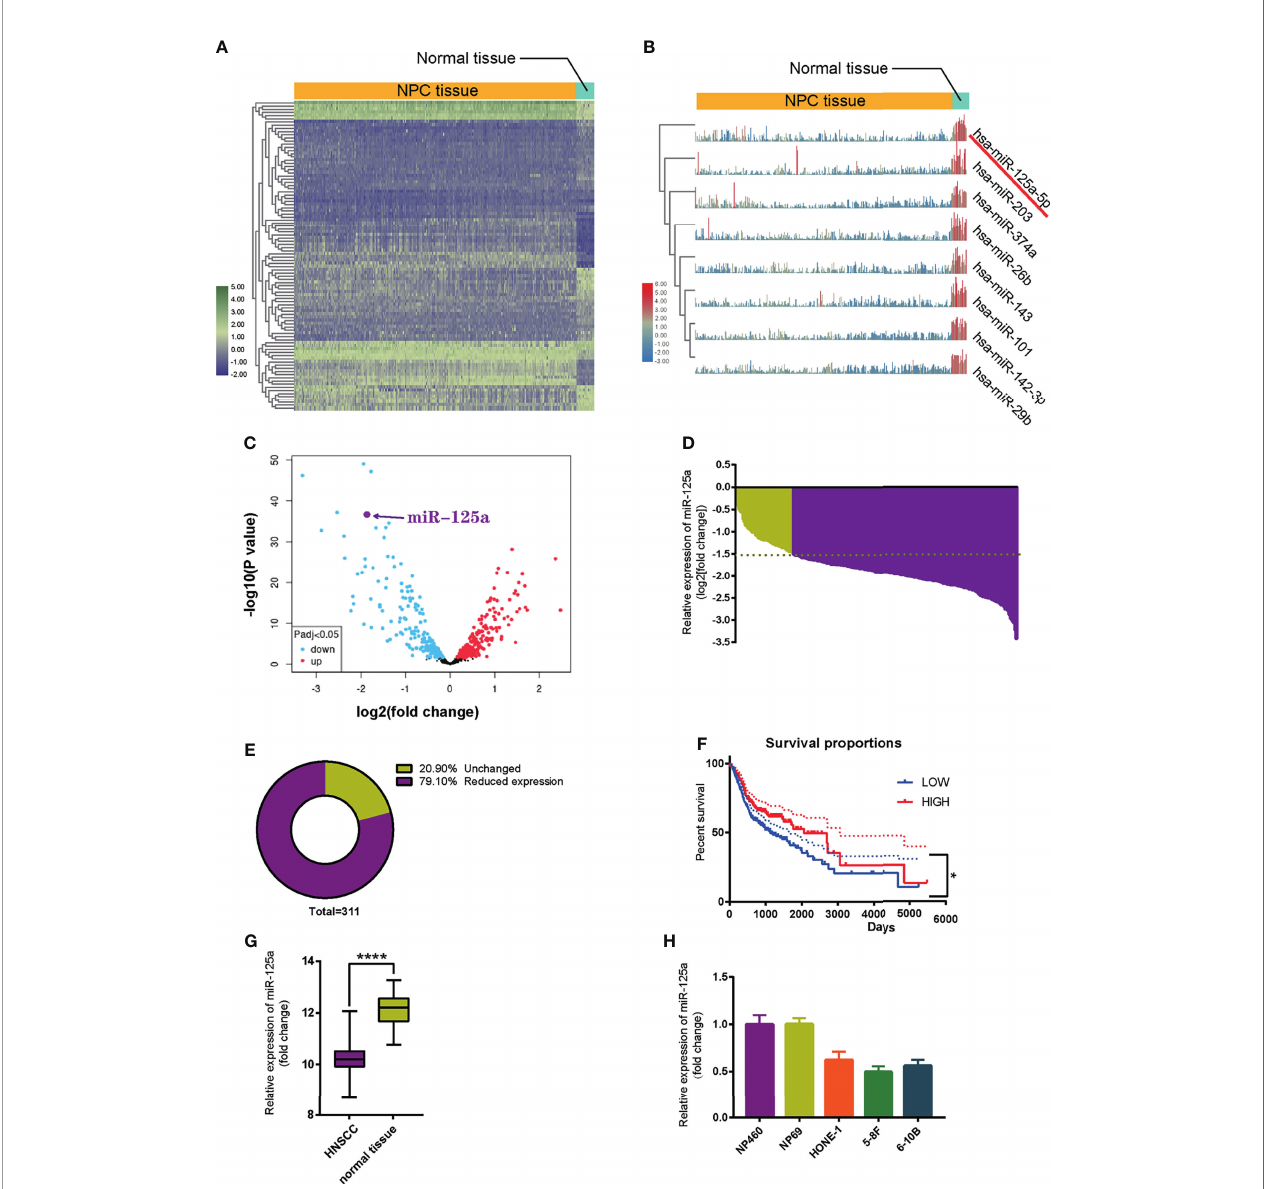
FIGURE 1 | MiR-125a is downregulated in NPC tissues and cell lines. (A) Heat map of top 250 differentially expressed genes. (B) Illustration of top 8 downregulated genes. (C) Volcano plot of differentially regulated microRNAs. (D) Waterfall plot for mir-125a expression level of each NPC patient (NCBI/GEO/GSE32960). (E) Pie chart summarizing percentage of miR-125a level of NPC patients, a fold change>2 or <1/2 was de fi ned as signi fi cant. (F) Kaplan – Meier survival curve in miR-125a low and high expression NPC cases (NCBI/GEO/GSE32960). (G) Box plot for miR-125a level in HNSCC and normal tissue in the TCGA database. (E, H) Relative mir-125a expression in normal nasopharynx cell lines and NPC cell lines. (*P < 0.05; ****P <